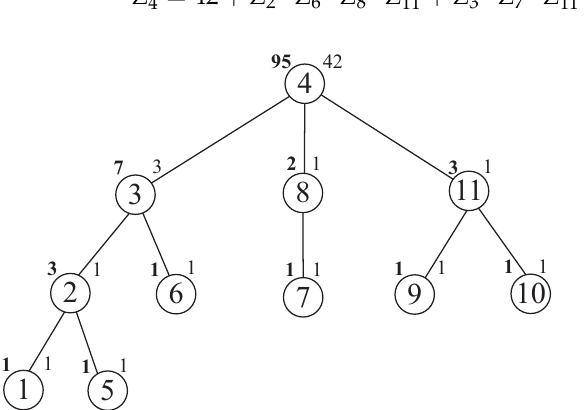
Figure 1. Hosoya indices in T 4